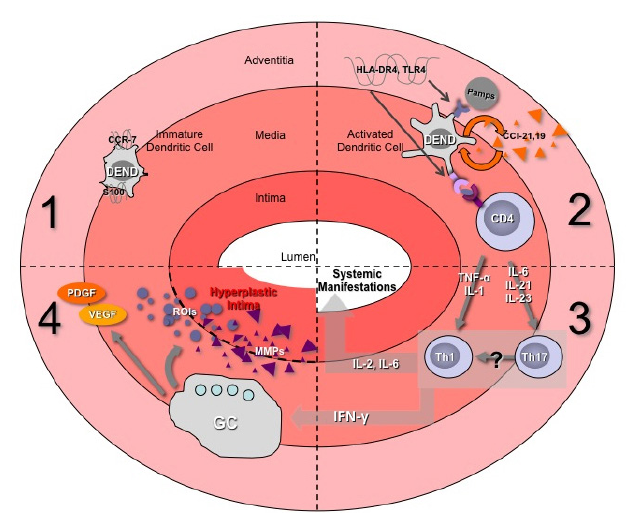
Fig. 1 – Immunopathology of the arterial wall in